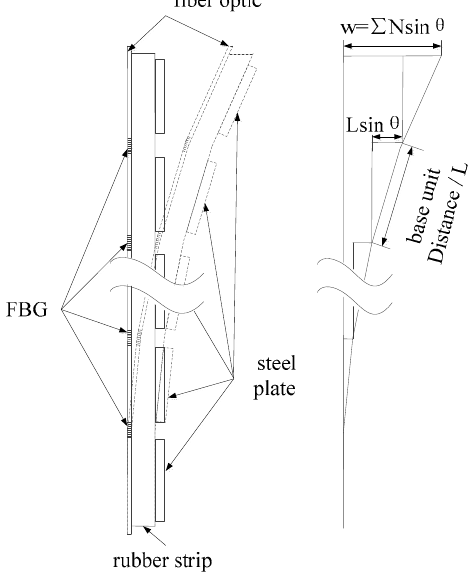
Figure 7. The FBG strain sensor and its measuring principle.